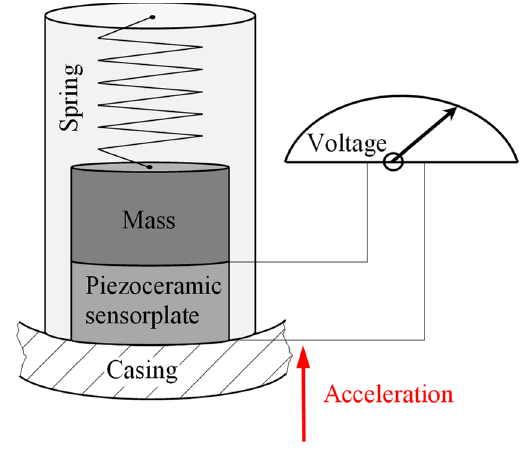
Figure 15. Principle accelerometer.